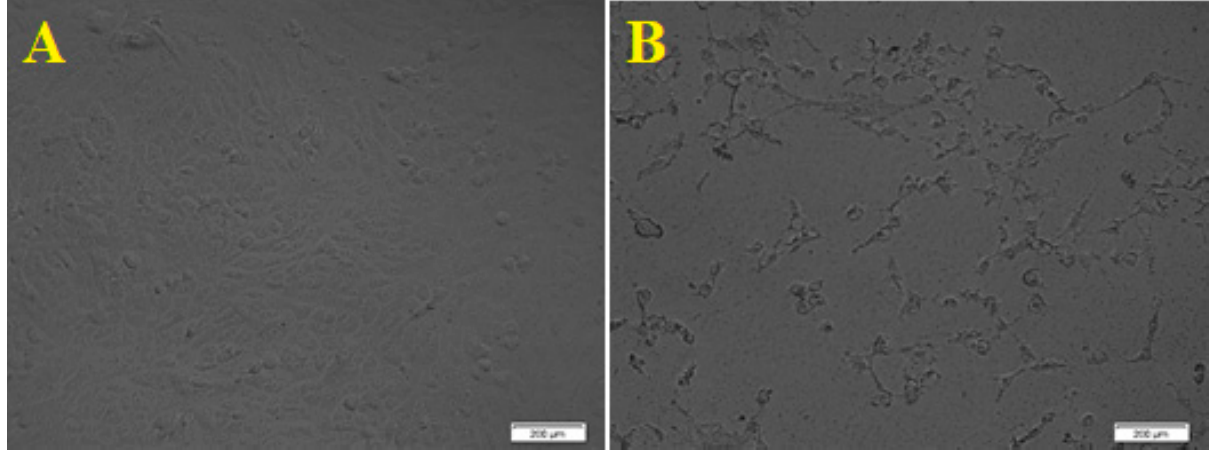
Figure 8. Cancer cell viability percentage on Hep-G2 cell line at various concentrations of ZnO NPs.